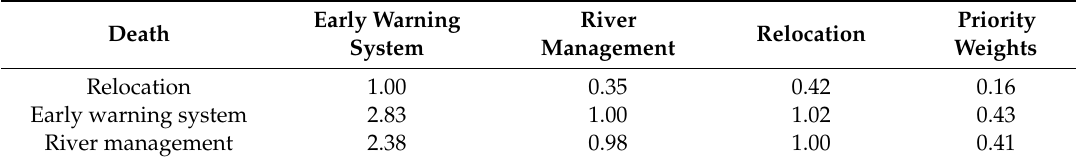
Table 5. Judgment matrix with respect to death reduction.